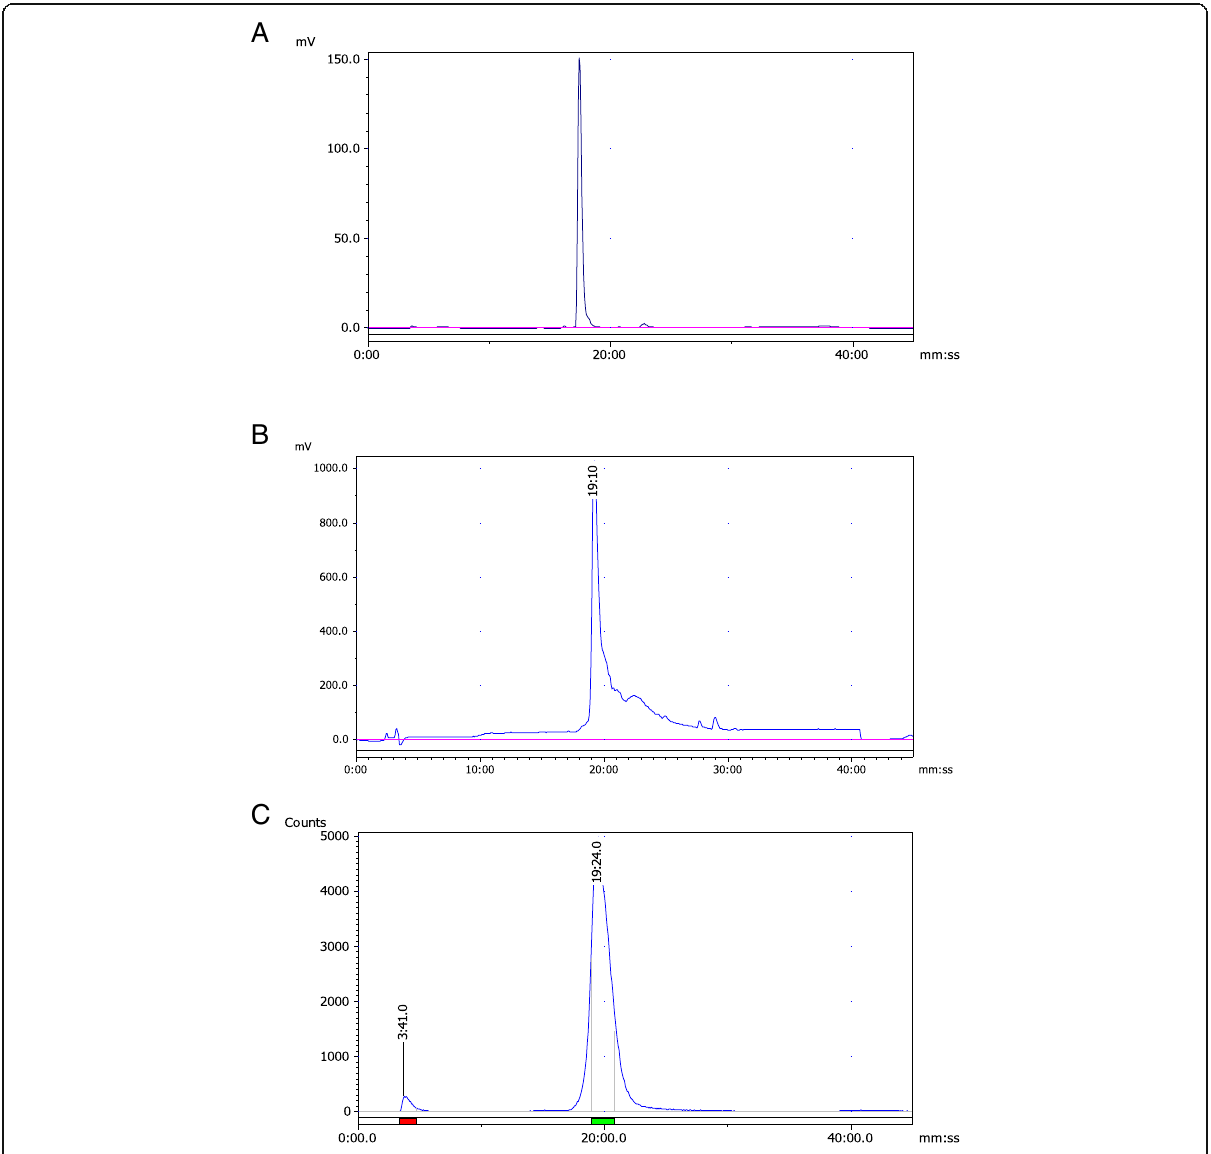
Fig. 5 Representative HPLC chromatograms of DOTA-Ahx-BN peptide. a DOTA-Ahx-BN peptide (UV: 220 nm); b DOTA-Ahx-BN peptide after labeling with cold nat Ga for identity confirmation (UV: 220 nm); c DOTA-Ahx-BN peptide after radiolabeling with radioactive 68 Ga. Note: UV detector connected before radioactive